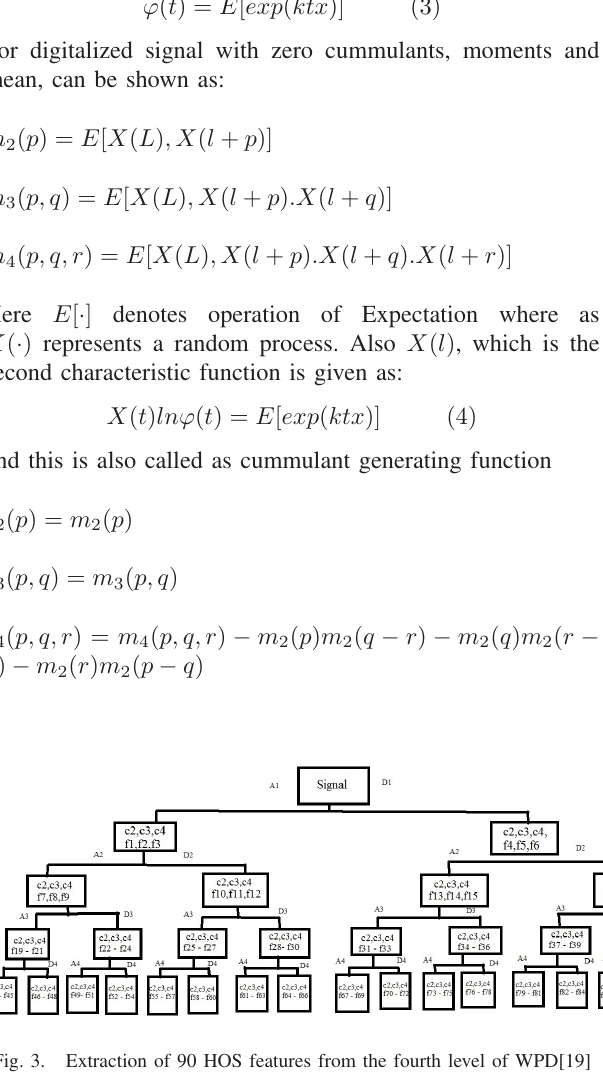
Fig. 3. Extraction of 90 HOS features from the fourth level of